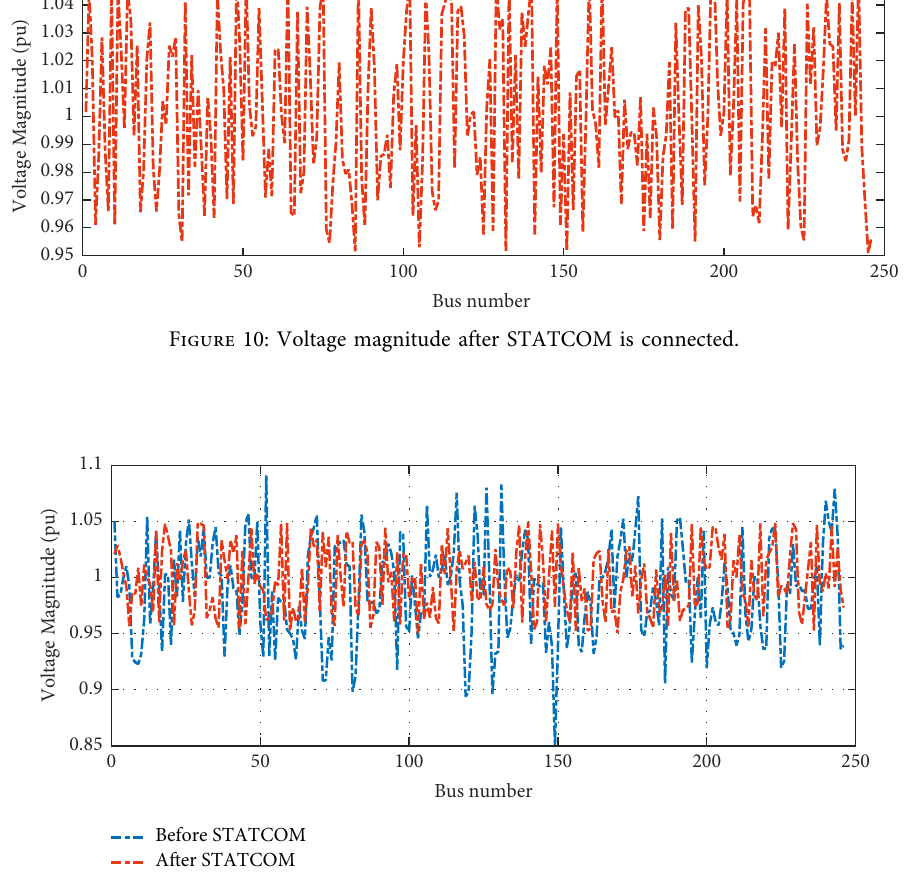
Figure 11: Comparison of voltage magnitude before and after STATCOM is connected.